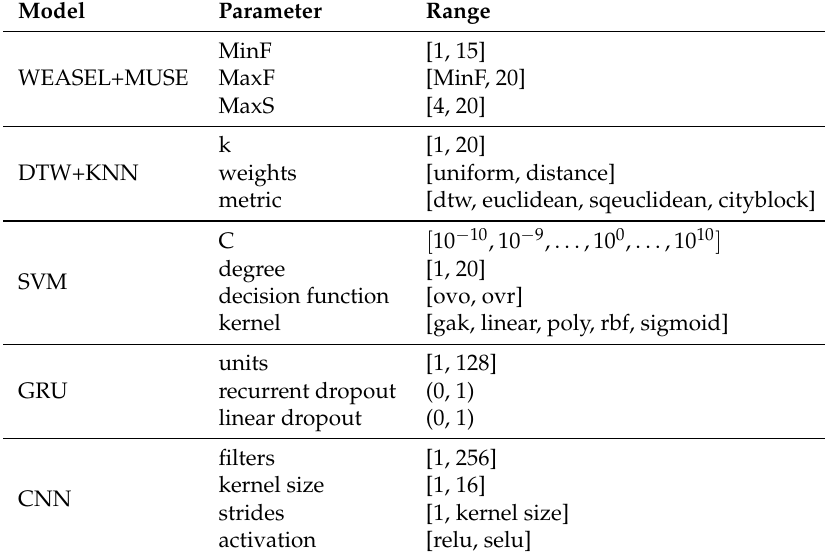
Table A1. Models and their parameters alongside their specific ranges used within the hyper-optimizing